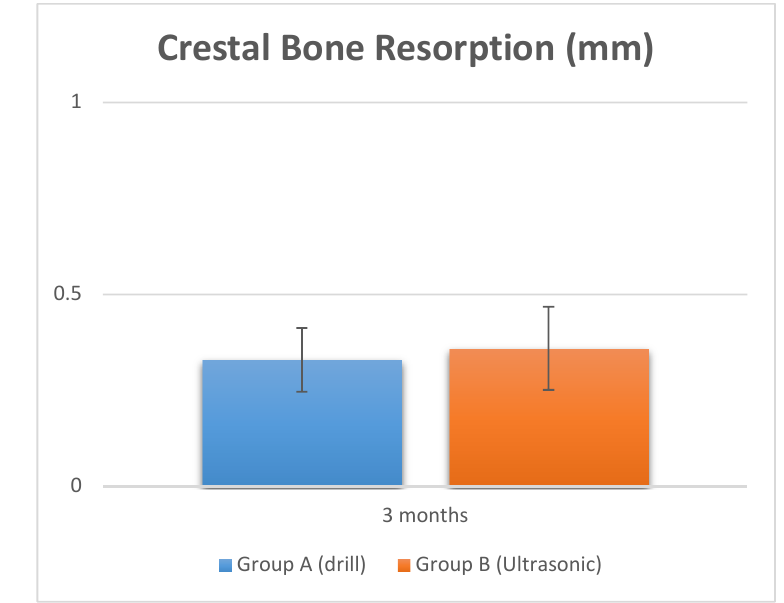
Figure 5. Crestal bone resorption at 3 months healing. Figure 4. Crestal bone resorption at 3 months healing. Figure 3. Operative surgery duration evaluated for the two study groups. Table 2. Summary of operative time of implant site preparation. The crestal bone resorption was also evaluated at 3 months.